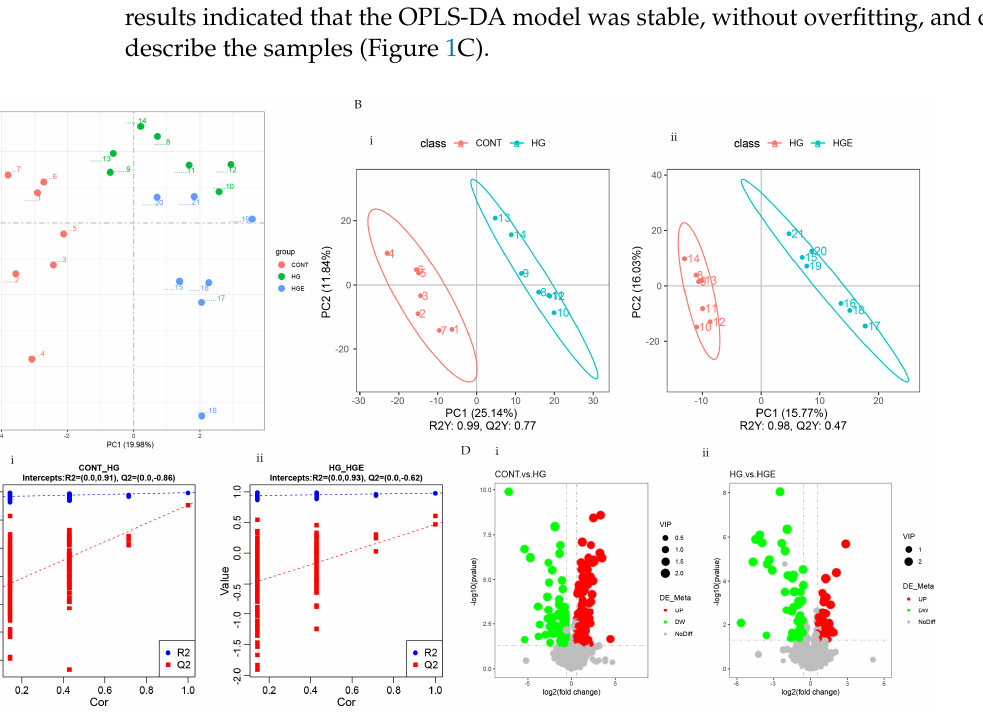
Figure 1. Effect of vitamin E on blood metabolism profile of subacute ruminal acidosis induced by high concentration. ( i ) CON-HG, ( ii ) HG-HGE. ( A ) Principal component analysis (PCA) scores plots, ( B ) projections to latent structures-discriminant analysis (PLS-DA) scores plots, ( C ) permutation test of the PLS-DA model, ( D ) volcano plots.